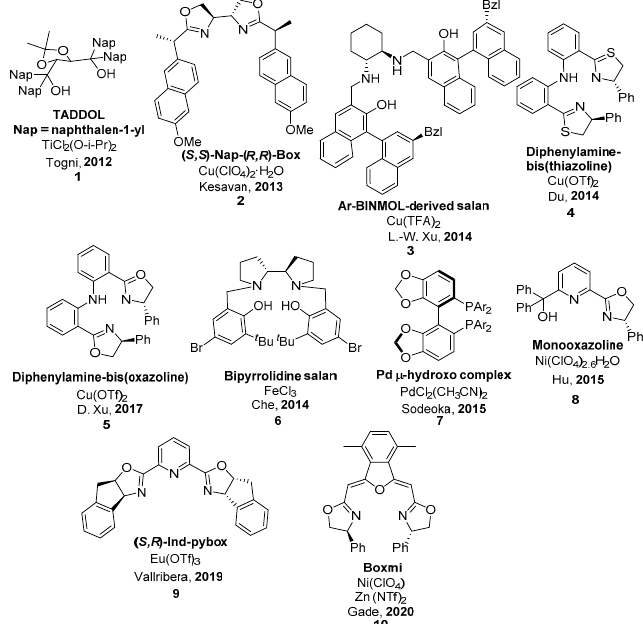
Figure 2. Chiral ligands and metals combinations for the catalytic enantioselective fluorination of β -keto